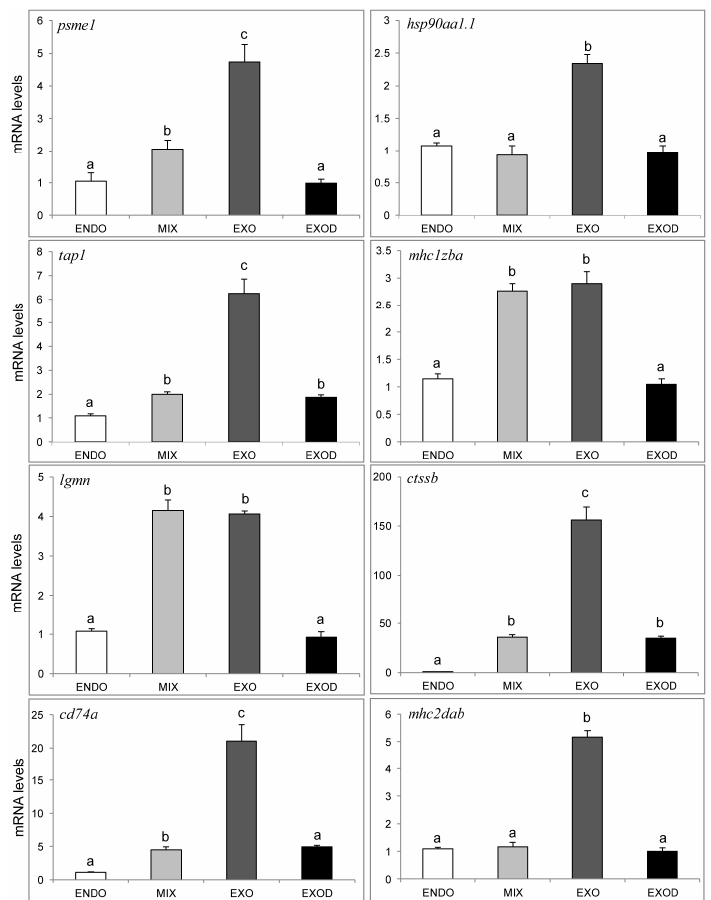
Figure 12. qPCR analysis of the genes related to antigen processing and presentation, including ENDO, MIX, EXO and EXOD groups. The proteasome activator ( psme1 ), heat shock protein 90 kDa α ( hsp90aa1.1 ), antigen transporter ( tap1 ), MHC class I ZBA ( mhc1zba ), legumain ( lgmn ), cathepsin Bb ( ctssb ), CD74 molecule ( cd74a ), and MHC class II DAB ( mhc2dab ) were detected. Data from qPCR are shown as mean ± standard deviation ( n = 3). Significant differences are marked by different letters ( p < 0.05).